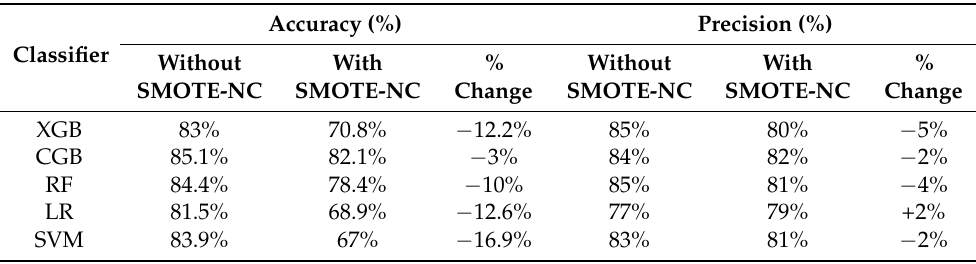
Table 5. Performance (accuracy and precision) of the 5 classifiers on diabetes-prediction balanced and unbalanced data.